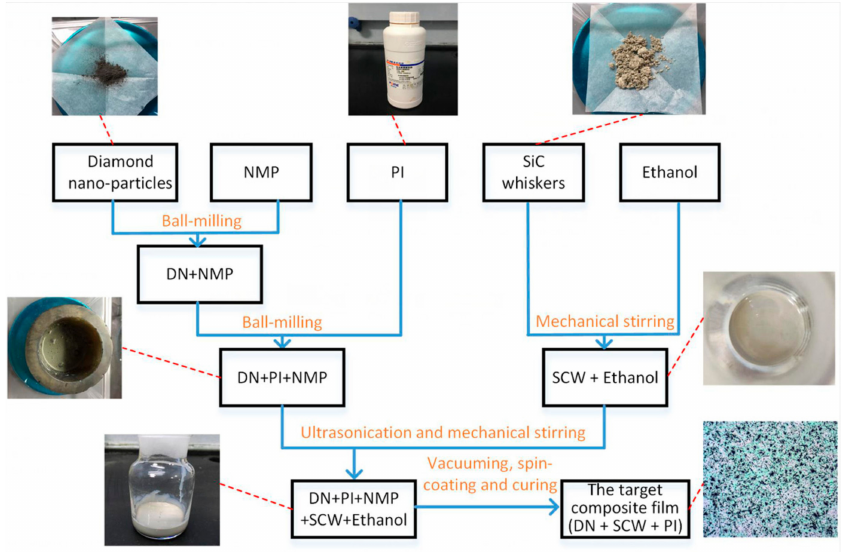
Figure 3. The preparation process of the composite